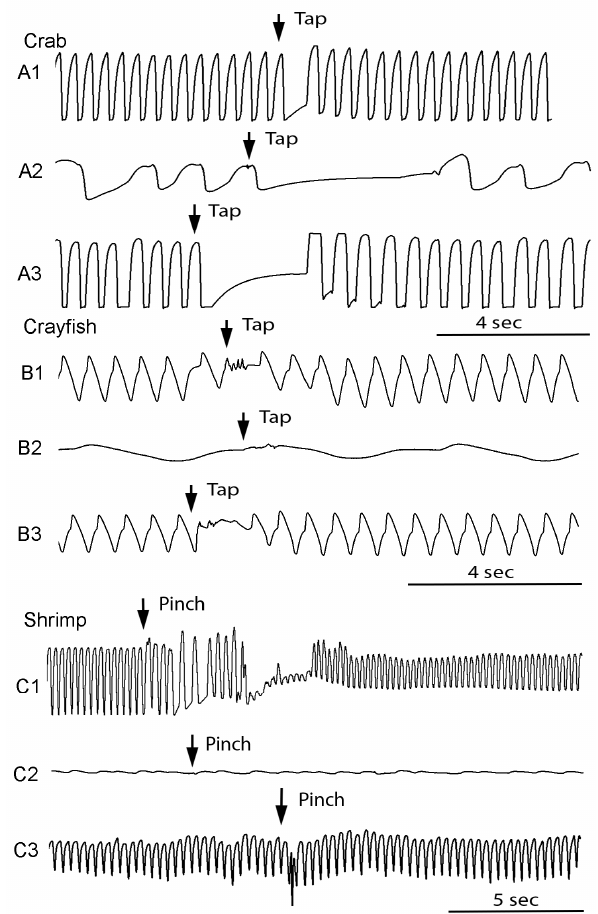
Figure 5. The change in heart rate with a sensory stimulus before (1), during (2), and after (3) immersion in ice slurry. Crab ( A1 ), crayfish ( B1 ) and Belize shrimp ( C1 ) show a marked response in the ECG trace when pinched on the telson (shrimp) or tapped on the dorsal carapace (crab and crayfish) before being immersed in a sea ice slurry. When immersed in cold water no changes could be detected in the ECG with a sensory stimulus for the shrimp. Note the amplitude after ECG trace for the crayfish and shrimp is reduced after just 30 s in the cold and no observable sensory-CNS-cardiac ganglion response can be detected ( B2 , C2 ). However, for crabs there was still some responsiveness to a sensory-CNS-cardiac ganglion response even after 2 min in the ice slurry ( A2 ). The heart rates of all animals rebounded quickly when placed back in the original water, and after 2 to 5 min all species showed responses to the same type of sensory stimuli ( A3 , B3 , C3 ). The traces shown are of the same gain and from the same animal during the different paradigms.